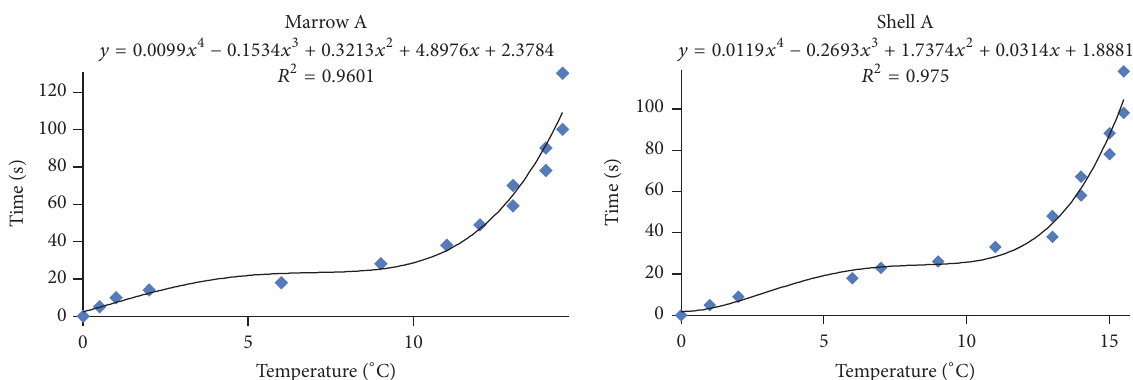
Figure 9: Correlation between changes in terms of temperature located 2mm from the irradiated surface and the heat diffusion length.